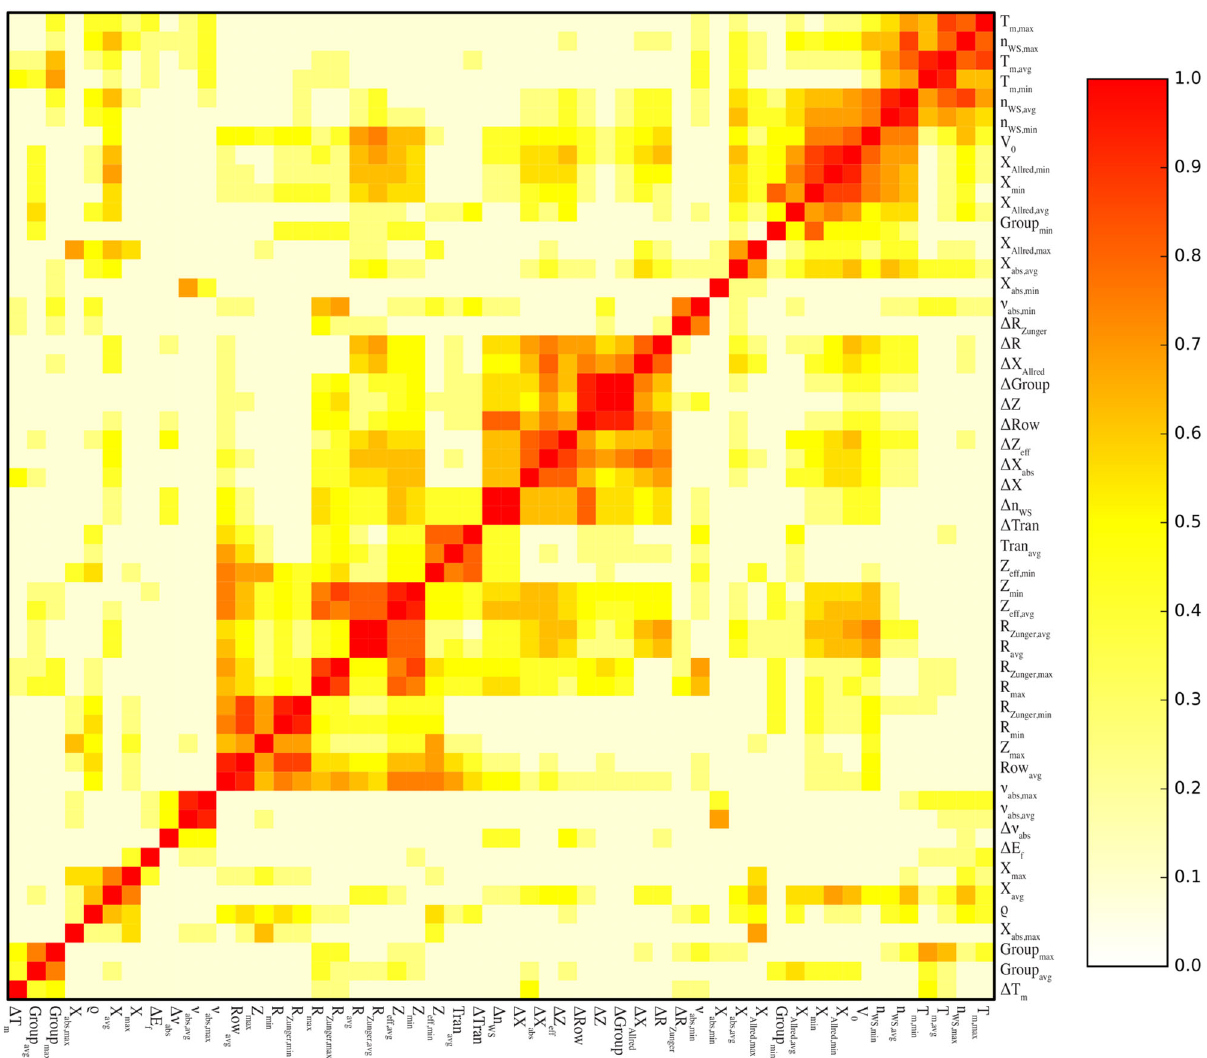
Fig. 3 Correlation between the predictors computed with Spearman ’ s rank correlation coef fi